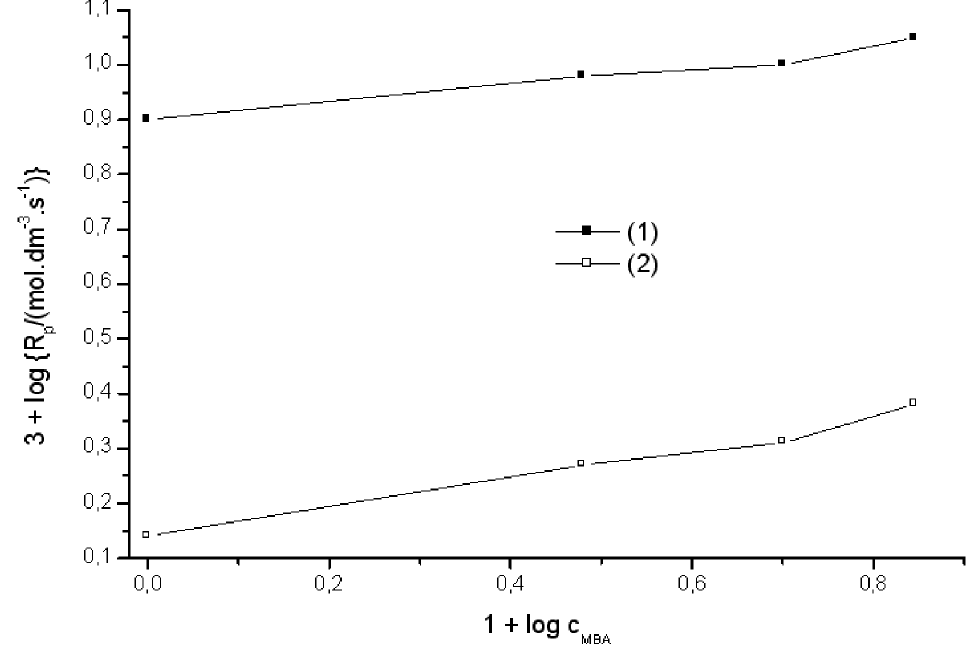
Fig. 3 Variation of the rate of polymerization in the inverse miniemulsion copolymerization of AAm with the MBA (c MBA /(g/100 g CH)) concentration (the log { log plot). (1): without MA (see Figs. 1 and 2), (2): with MA (see Figs. 4 and 5).